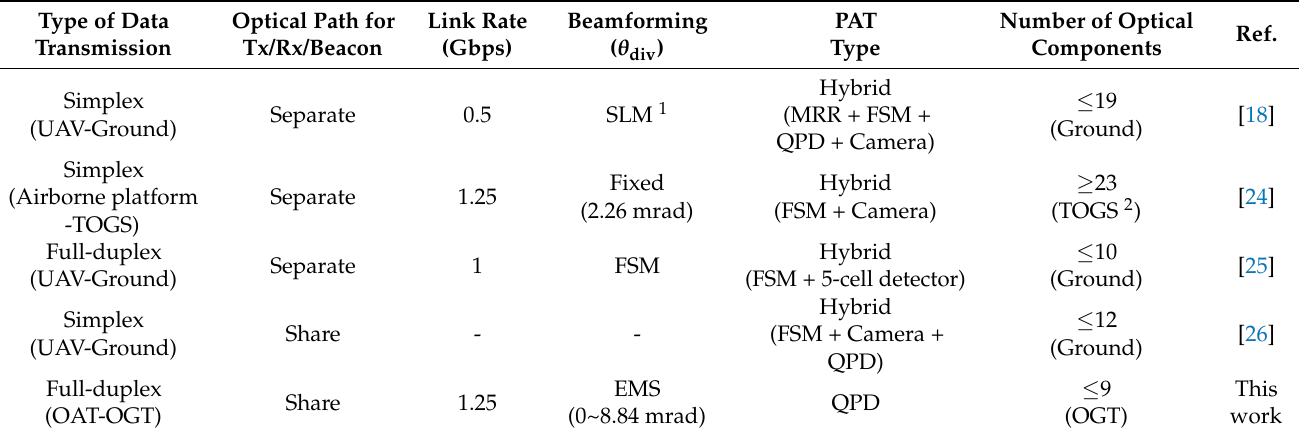
Table 1. FSO communication system for UAVs with PAT